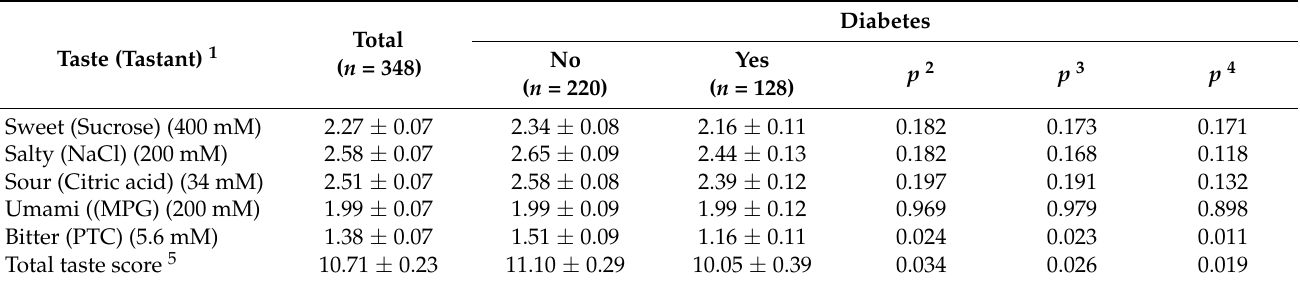
Table 3. Taste perception (sweet, salty, sour, umami and bitter) in the whole population and stratified by type 2 diabetes.